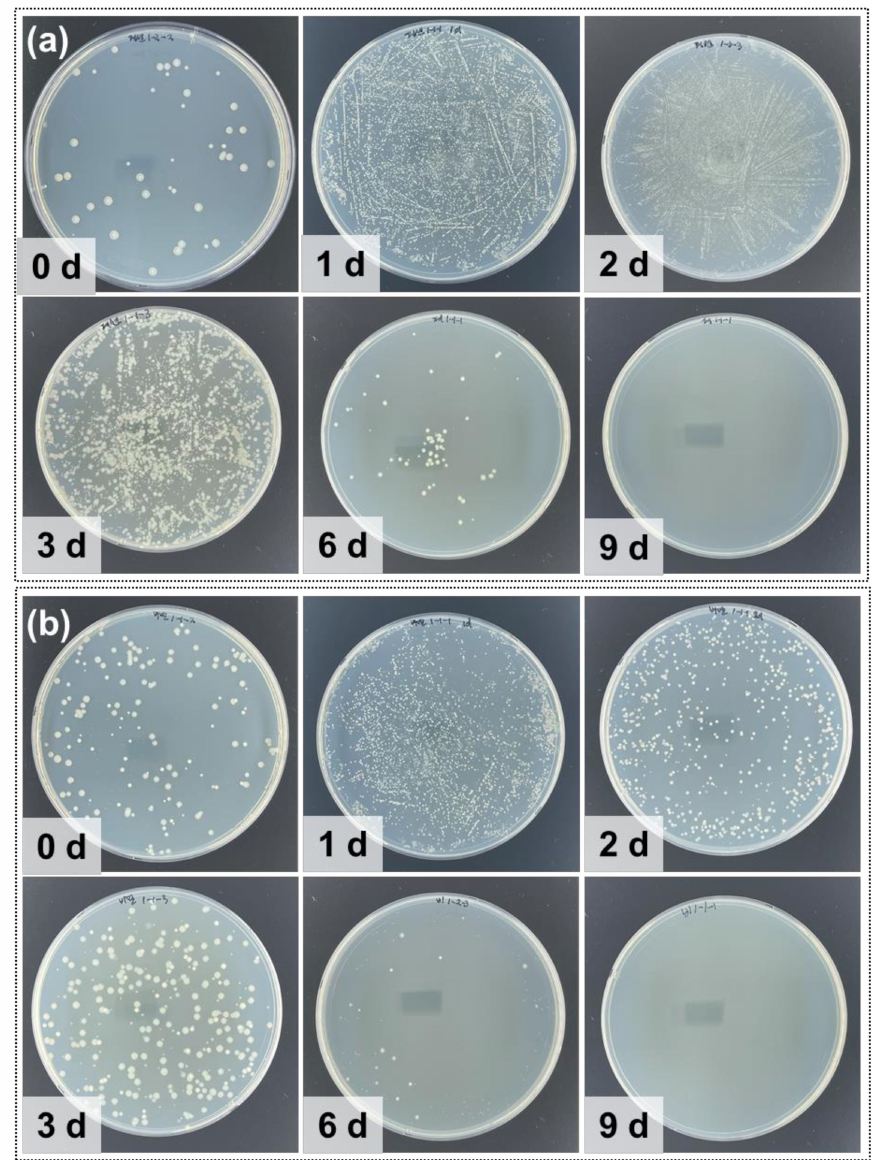
Figure 4. Photographs of B. subtilis grown on agar plates after the B. subtilis -containing bioaerosols were filtered by ( a ) woven and ( b ) anti-droplet